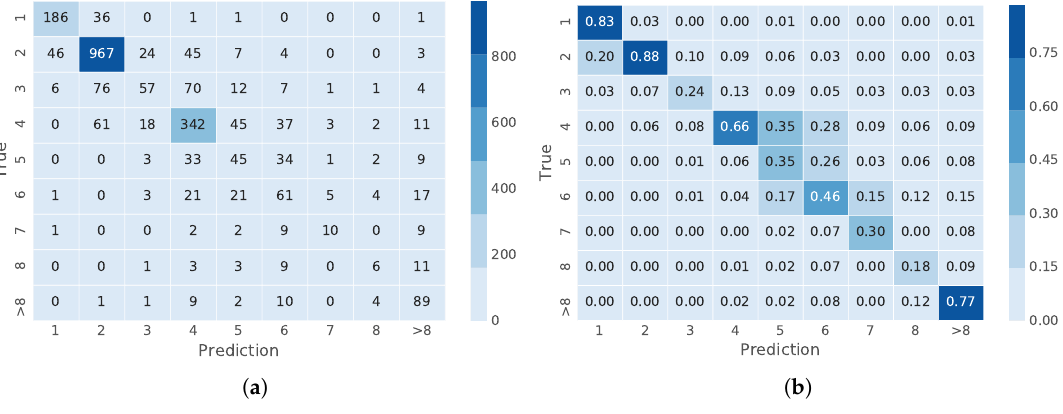
Figure 7. Distribution of predicted growth stages of weeds. ( a ) confusion matrix; ( b ) normalized confusion